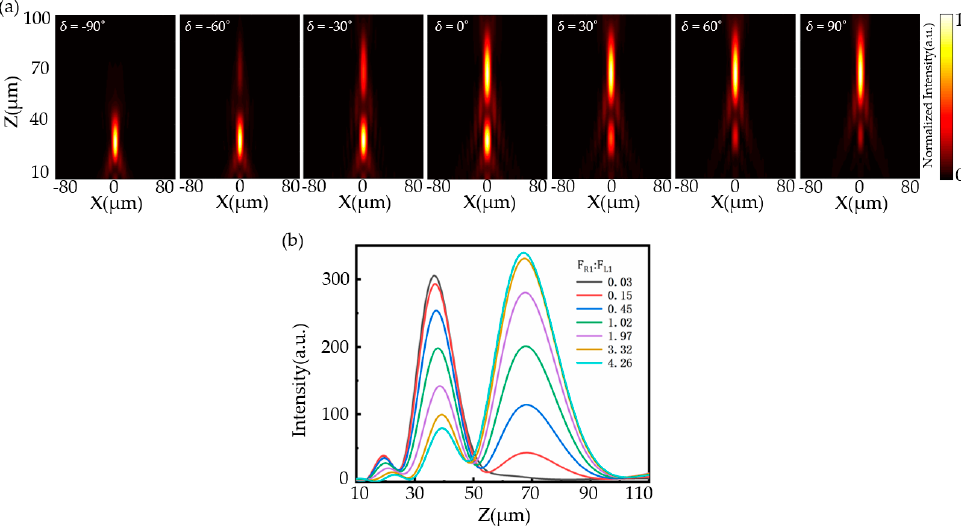
Figure 7. ( a ) The relative electric field intensity profiles of two focal points in the x − z plane for the different phase difference δ . ( b ) Demonstration of intensity distribution at the longitudinal focal length.